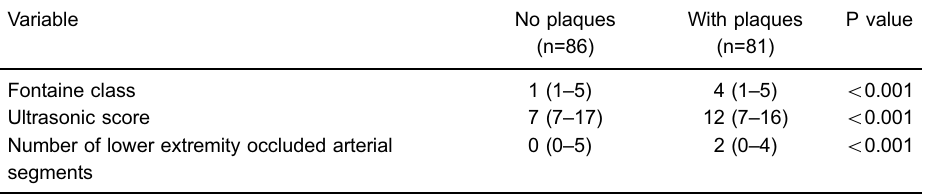
Table 5. Comparison of Fontaine class, ultrasonic score, and number of lower extremity occluded segments between subgroups based on the presence/absence of internal carotid artery